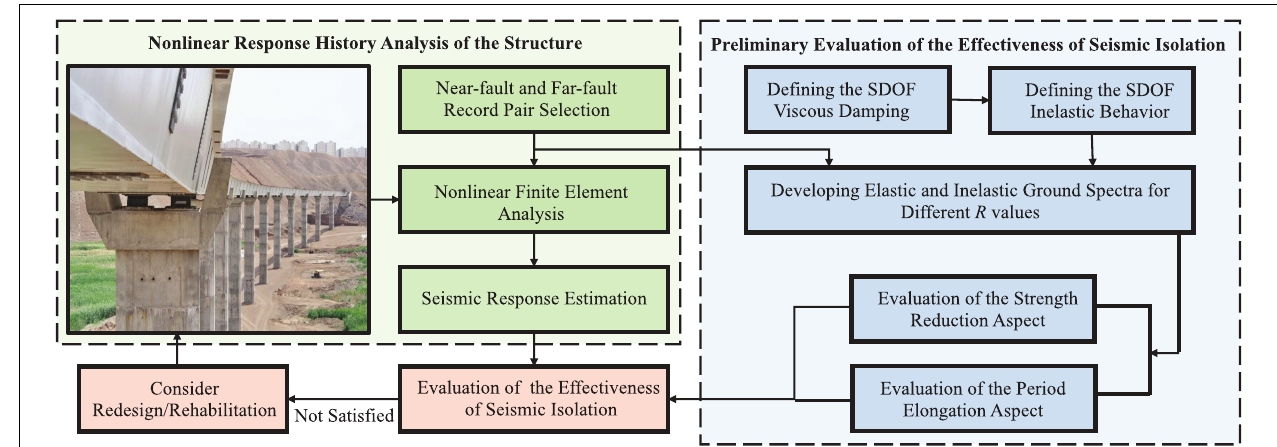
FIGURE 2 | Summary of the adopted method of approach to evaluate the effectiveness of seismic isolation.